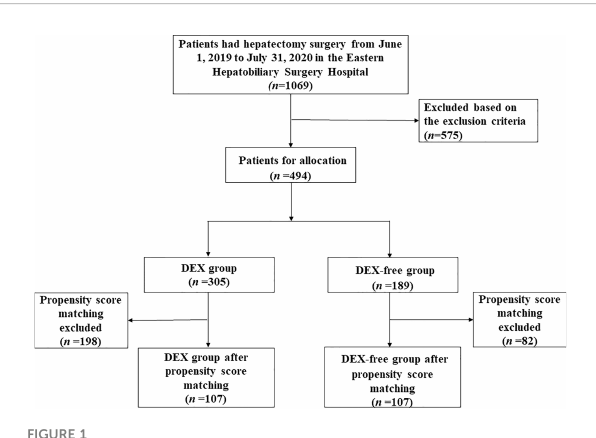
FIGURE 1 Flow diagram detailing the selection process for patients in this